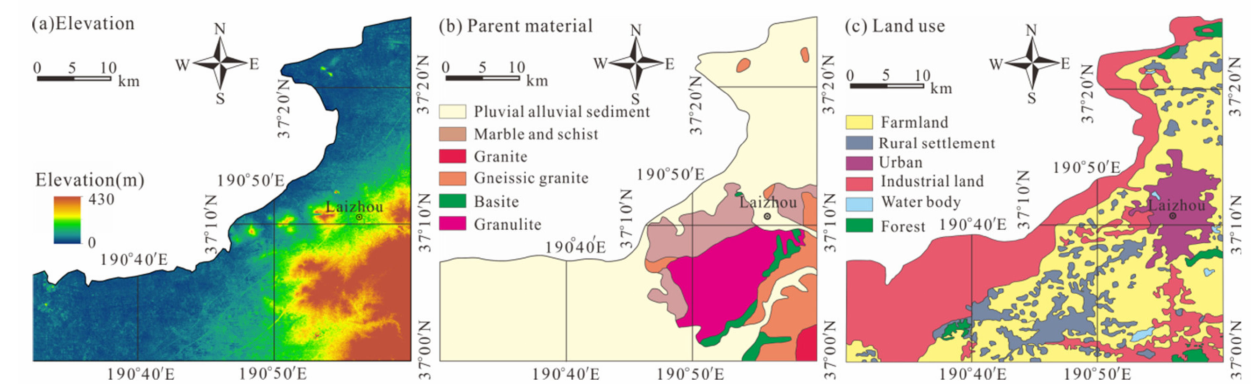
Figure 2. Land use, parent material and topography in Laizhou (( a ) from the SRTMDEM 90M; ( b ) was adapted from the geological map of Yantai city (map scale, 1:250,000); ( c ) was interpreted in GF-2 1M).